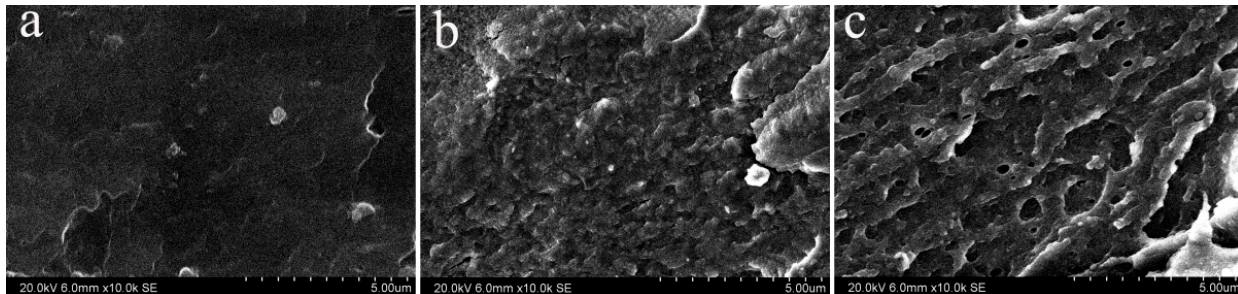
Figure 8. SEM micrographs of the fracture surface. ( a ) unirradiated ETFE after 504 h aging treatment; ( b ) irradiated ETFE after 504 h aging treatment at a dose of 60 kGy; ( c ) irradiated ETFE after 504 h aging treatment at a dose of 120 kGy.